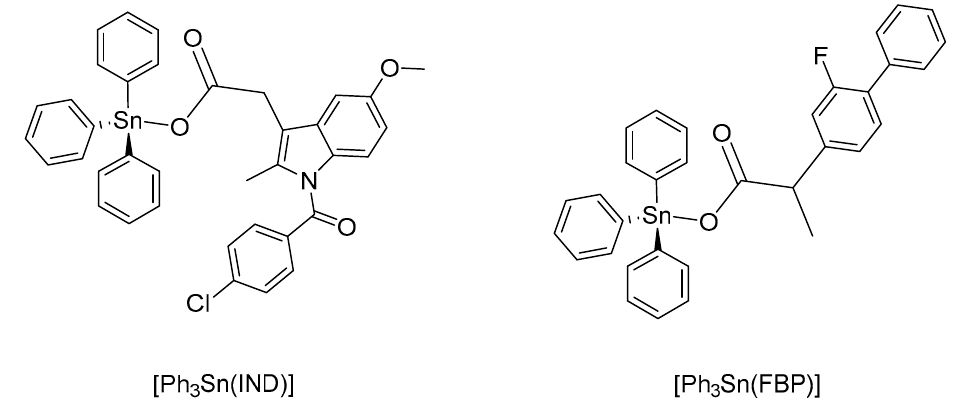
Figure 1. Organotin(IV) carboxylates: triphenyltin(IV) indomethacinate, [Ph 3 Sn(IND)], and triphenyltin(IV) flurbiprofenate, [Ph 3 Sn(FBP)].